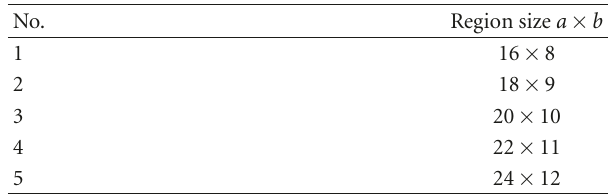
Figure 9: Energy sensitivity of historical query record. Table 4: Setting query region size.